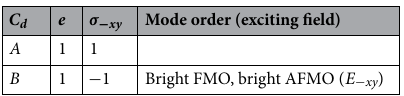
Table 5. IRREPs of group C d , mode order and exciting E ext -field.